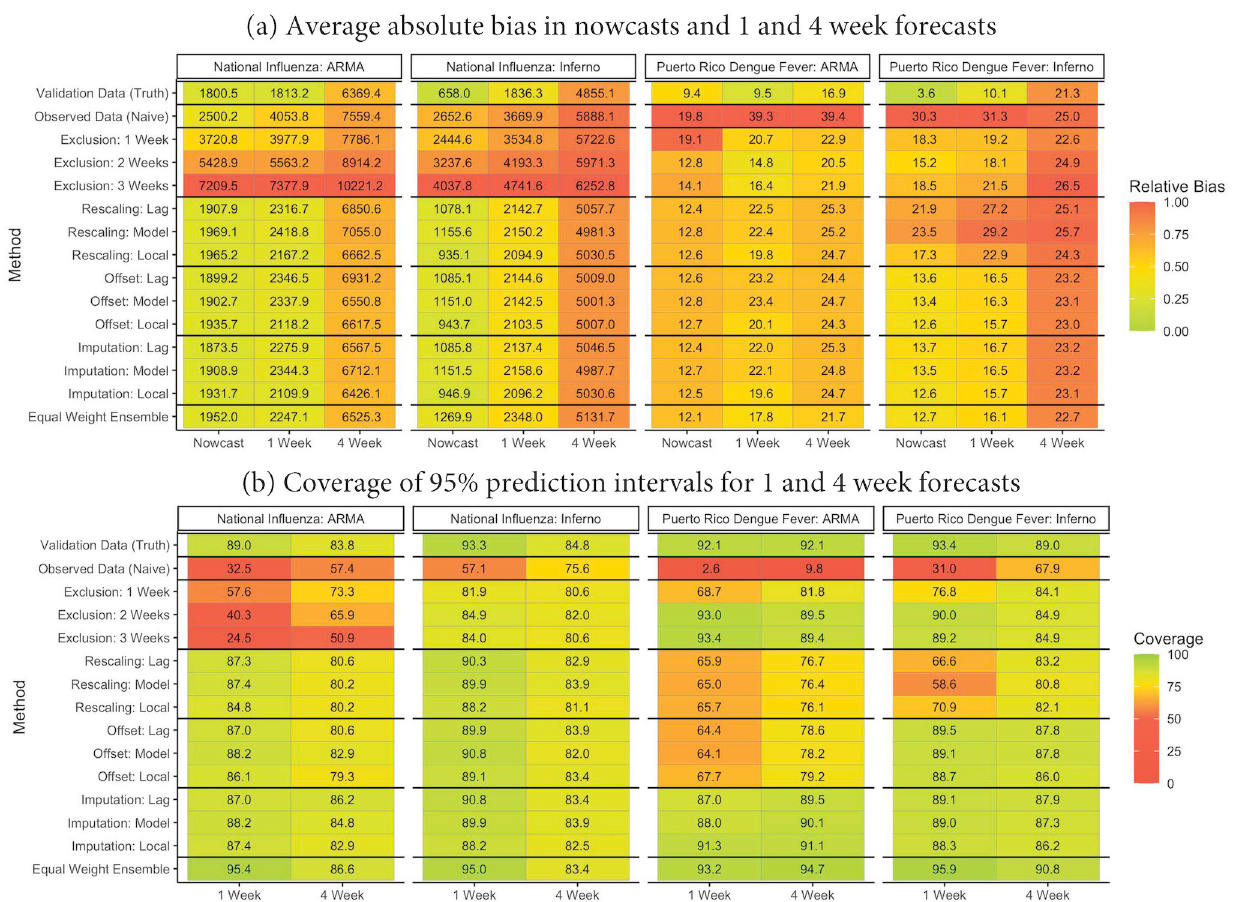
Fig 3. Performance of nowcasts and forecasts in the Puerto Rico dengue fever and national US influenza-like illness data across all weeks 1 . 1 Results for dengue fever are aggregated across each of 50 weeks in 18 seasons (1992–2009). Results for US national influenza are aggregated across 35 weeks in 7 seasons. The ensemble method corresponds to an equal-weight linear combination of all methods except validation data analysis. “Model” indicates that reporting factors were estimated via regression and allowed to vary by t and s . “Lag” indicates that reporting factors were estimated via Eq 6. “Local” indicates that reporting factors were estimated via Eq 8. Relative absolute biases are calculated relative to the largest value in each column.